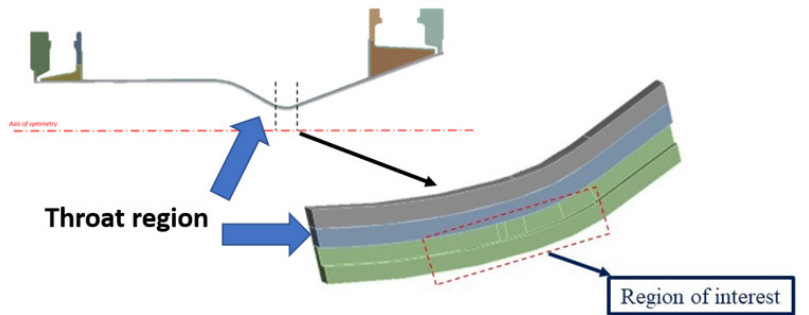
Figure 4. Global model (up), submodel with highlight of the region of interest where to focus the analysis of numerical results (down) [5].